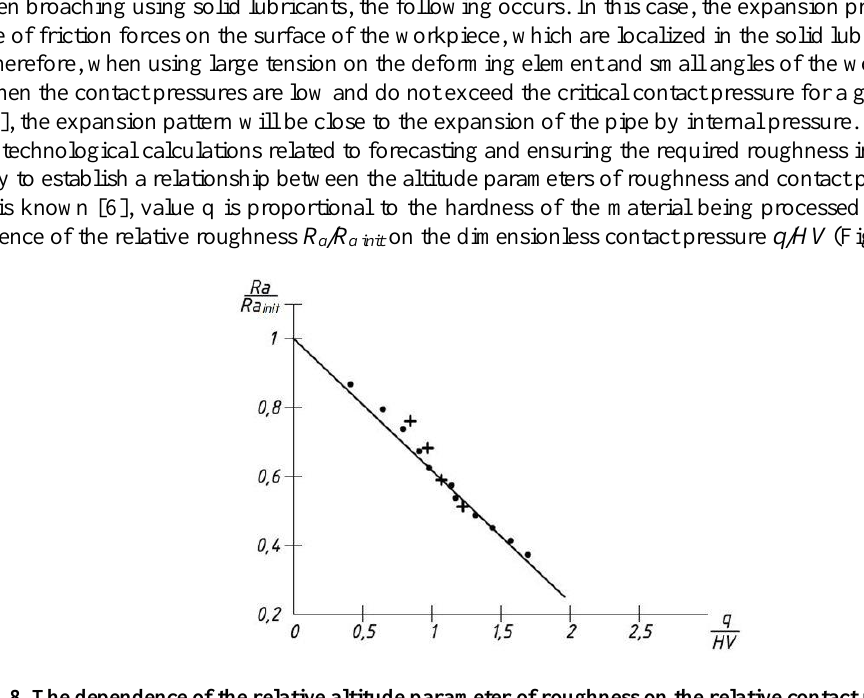
Fig. 8. The dependence of the relative altitude parameter of roughness on the relative contact pressure during the processing of titanium billets VT1-0 (●): t 0 /d 0 =0,21, a 0 /d 0 =0,028; from stainless steel 12H18N10T (  ): t 0 /d 0 =0,22, a 0 /d 0 =0,014